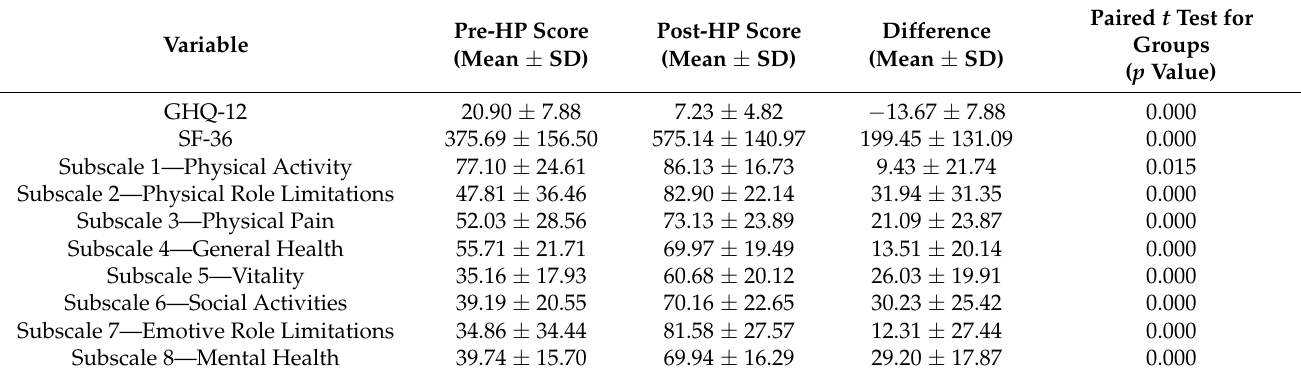
Table 1. GHQ-12 and SF-36 mean scores before and after treatment.